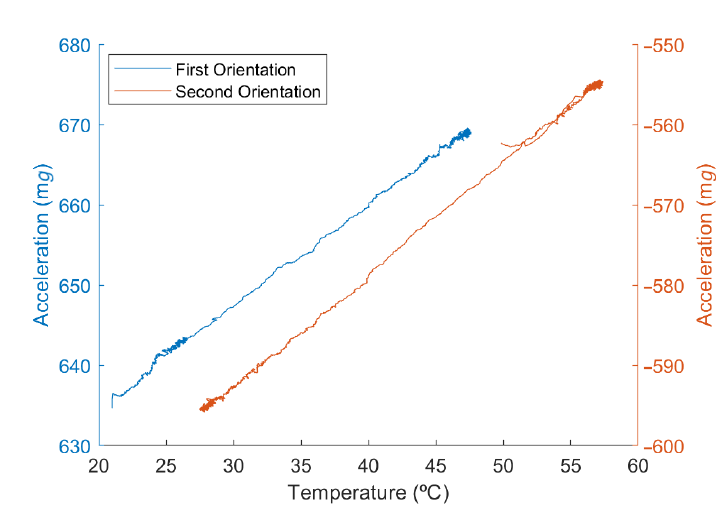
Figure 10. Acceleration vs. temperature in both test